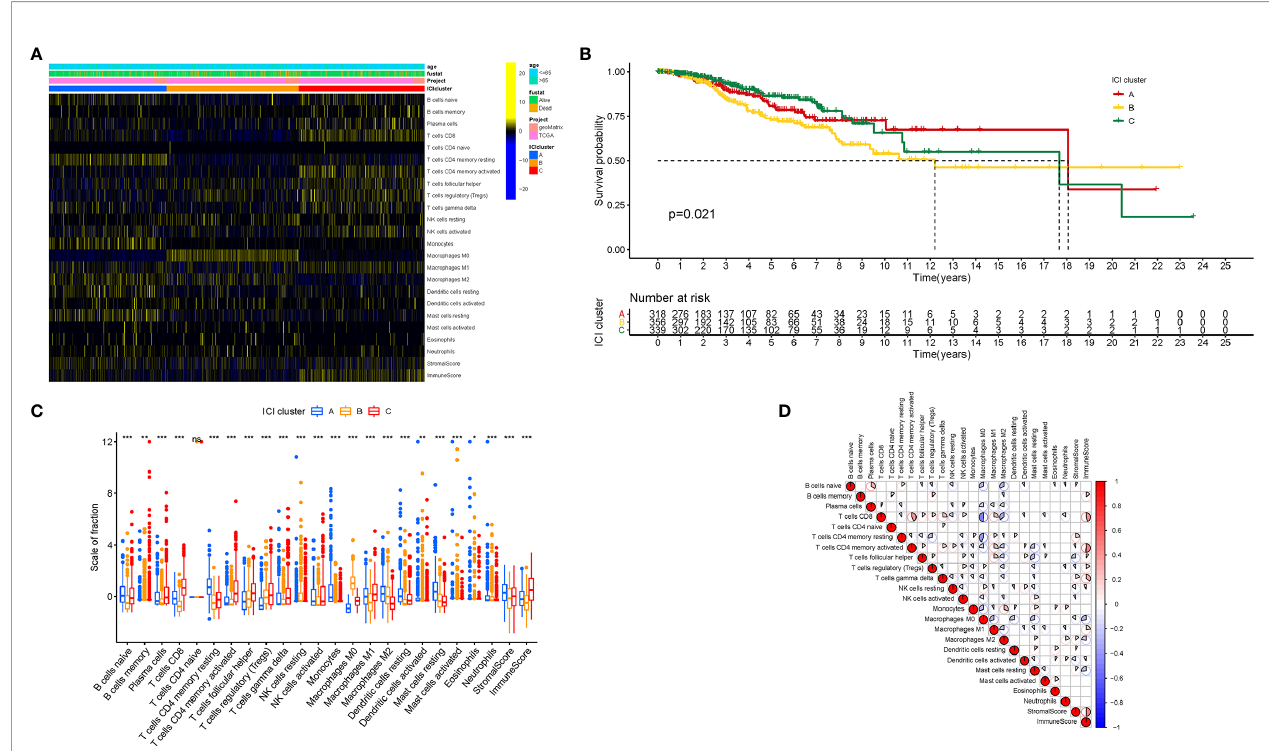
FIGURE 1 | The Landscape of Immune Cell In fi ltration in the TIME context. (A) Unsupervised clustering of tumor-in fi ltrating immune cells in BRCA patients. Rows represent tumor-in fi ltrating immune cells, and columns represent samples. (B) Kaplan-Meier curves for the overall survival (OS) of all BRCA patients in discrete ICI clusters. (C) The subpopulation of in fi ltrating immune cells, immune score, and stromal score in three ICI clusters. (D) Intrinsic connection of the in fi ltrating immune cells and immune scores. The asterisks represented the statistical p value (*P < 0.05; **P < 0.01; ***P < 0.001), ns, No Signi fi